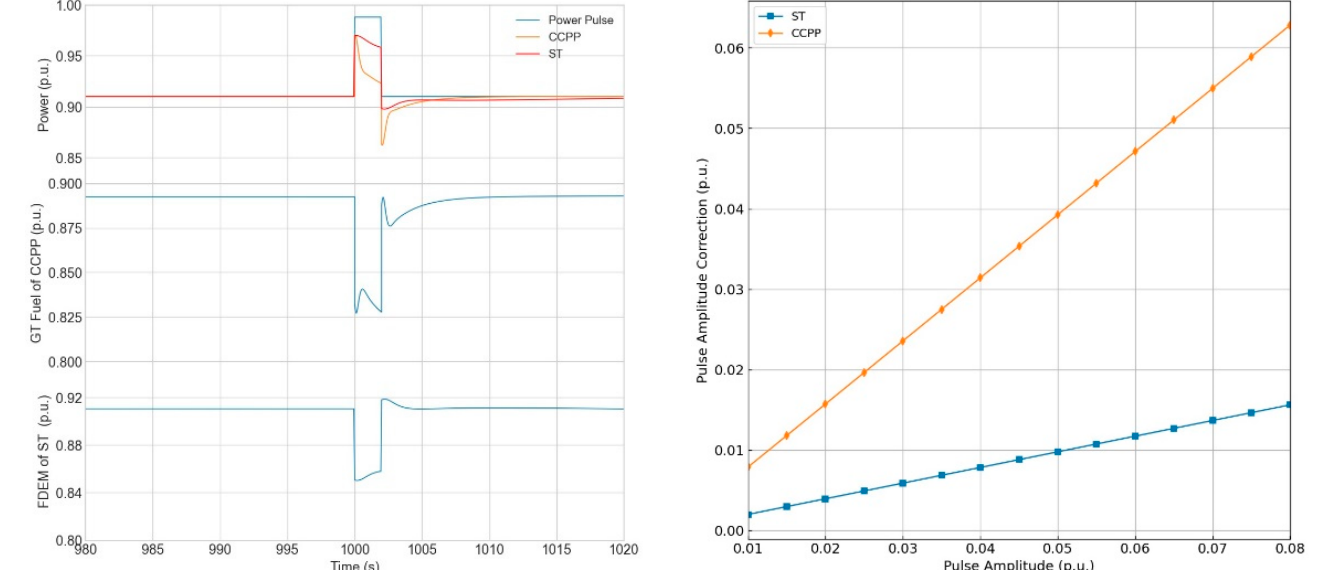
Figure 7. Pulsing load mutation of CCPP and ST.